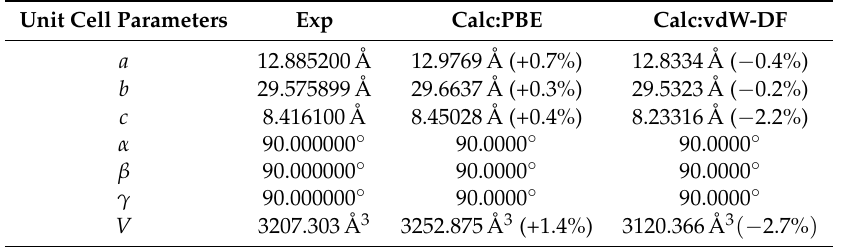
Table 3. Unit cell parameters of κ -Cl obtained from X-ray diffraction measurements at 100K (left column), ab initio calculations based solely on PBE functional (central column) and on vdW-DF functional (right column). Relative deviations from experimental values are given in